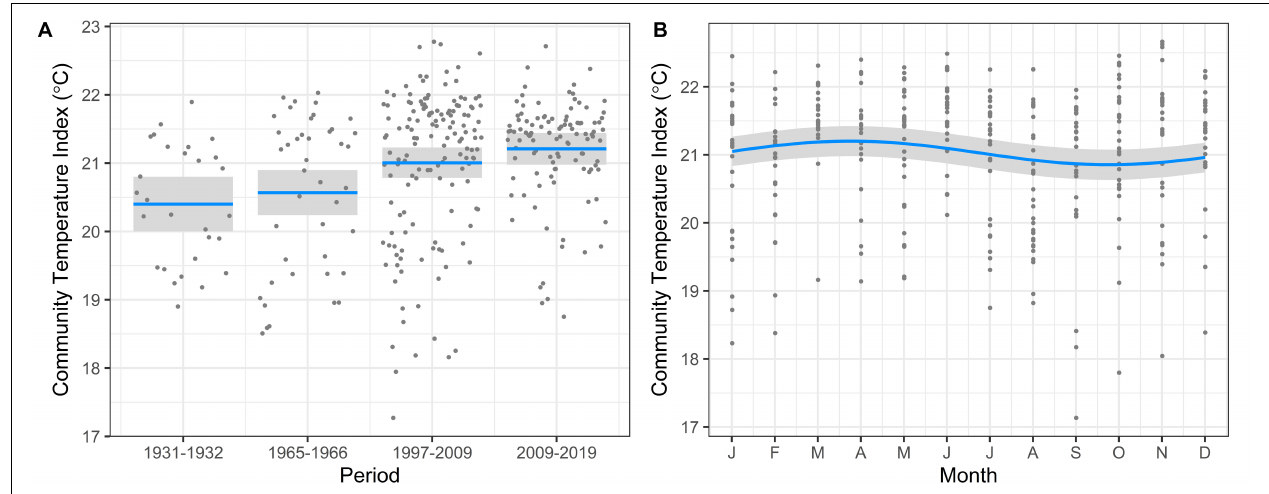
FIGURE 4 | Model output showing variation in Community Temperature Index in response to (A) Time period, and (B) Month, over 90 years of phytoplankton abundance data from PH 100m . Mean CTI shown by blue line and 95% confidence intervals by shaded areas.